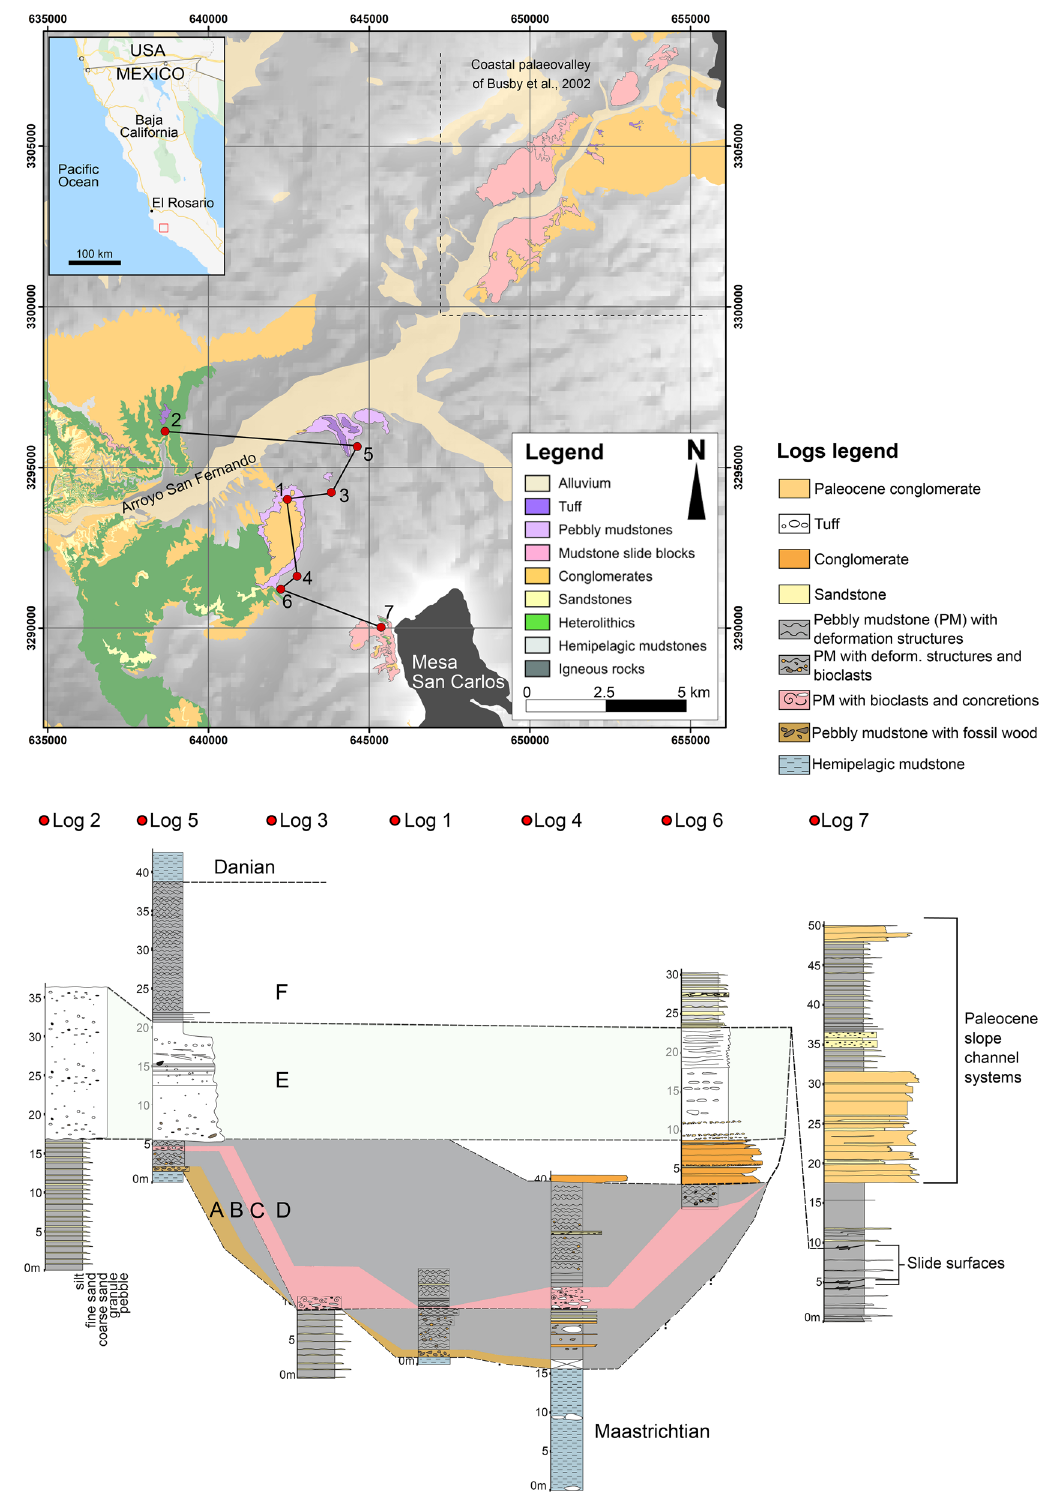
Figure 2. Log correlation of K–Pg-related deposits; main lithologies, structures, and fossils, within upper Maastrichtian and lower Danian hemipelagic mudstones. Panel is hung on correlative horizons that are present in three or more sections. Penecontemporaneous conglomerate deposits are unrelated to the K–Pg event and form part of channel systems that are ubiquitous in this stretch of the Pacific margin. Base map generated from: Esri, HERE, Garmin, Intermap, increment P Corp., GEBCO, USGS, FAO, NPS, NRCAN, GeoBase, IGN, Kadaster NL, Ordnance Survey, Esri Japan, METI, Esri China (Hong Kong), (c) OpenStreetMap contributors, and the GIS User Community. Map produced using ArcMap 10.7: https:// www. esri. com/ en- us/ arcgis/ produ cts/ arcgis- deskt op/ resou